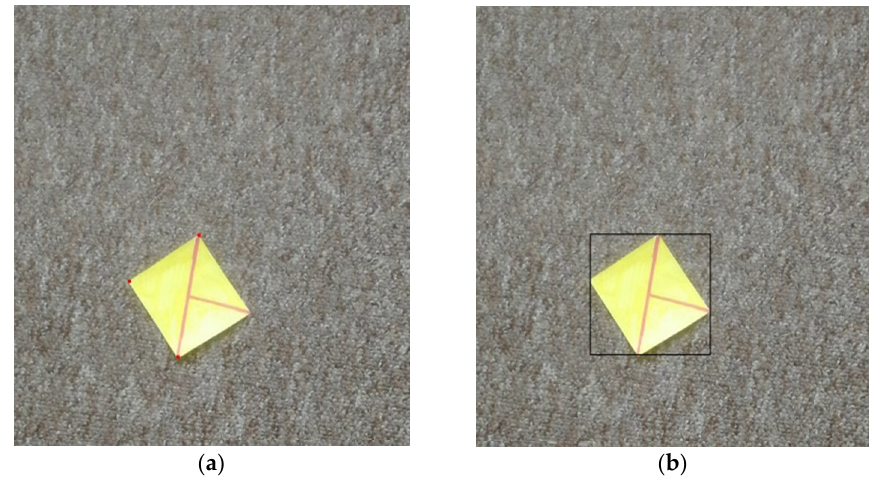
Figure 19. Illustration of the tagging process ( a ) three red points are placed ( b ) the points are replaced with the bounding box after the fourth point is placed. The dataset was divided into 385 train images, 110 validation images, and 55 test images. The training was performed for 50 epochs, with the best results gained at epoch 37. Out of 55 images, four false negative cases and one false positive case were detected with the default detection threshold of 0.3 (see Table 6). Table 6. Testing the “T cross” marker shape with real hand-drawn markers in natural scenes on a dataset of 550 images was carried out with various detection probability thresholds in the range of 0.05 to 0.7. Marker Detection Shape Threshold